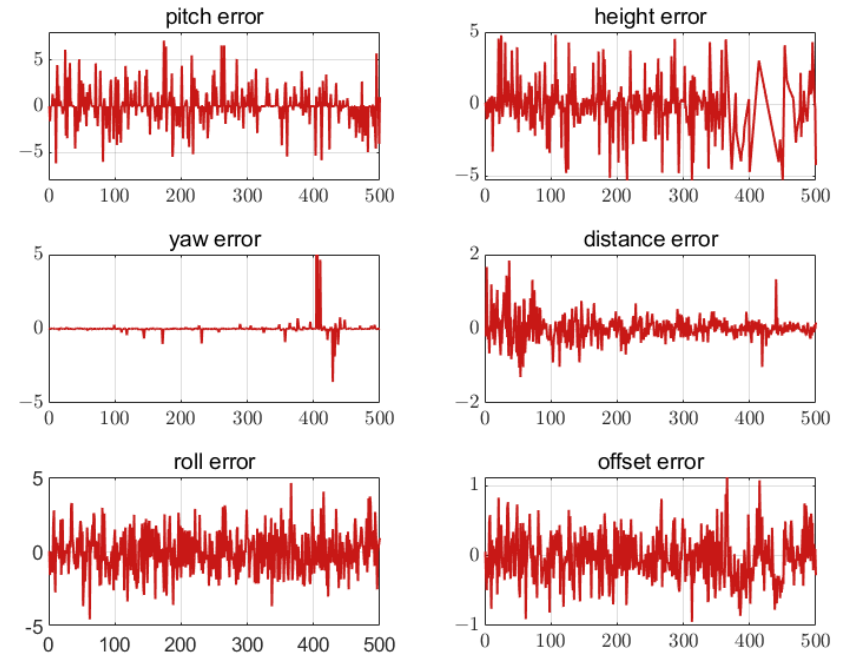
Figure 19. Error of five feature points. The unit of the attitude error is degree. The unit of the position error is meter. The horizontal axis in all figures is the number of measurement